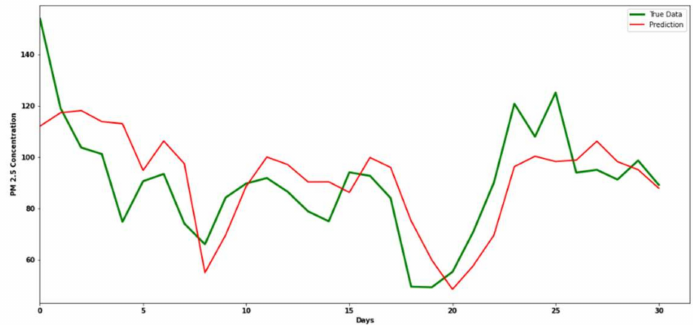
Figure 17. Forecasting for the next month for Islamabad using the LSTM